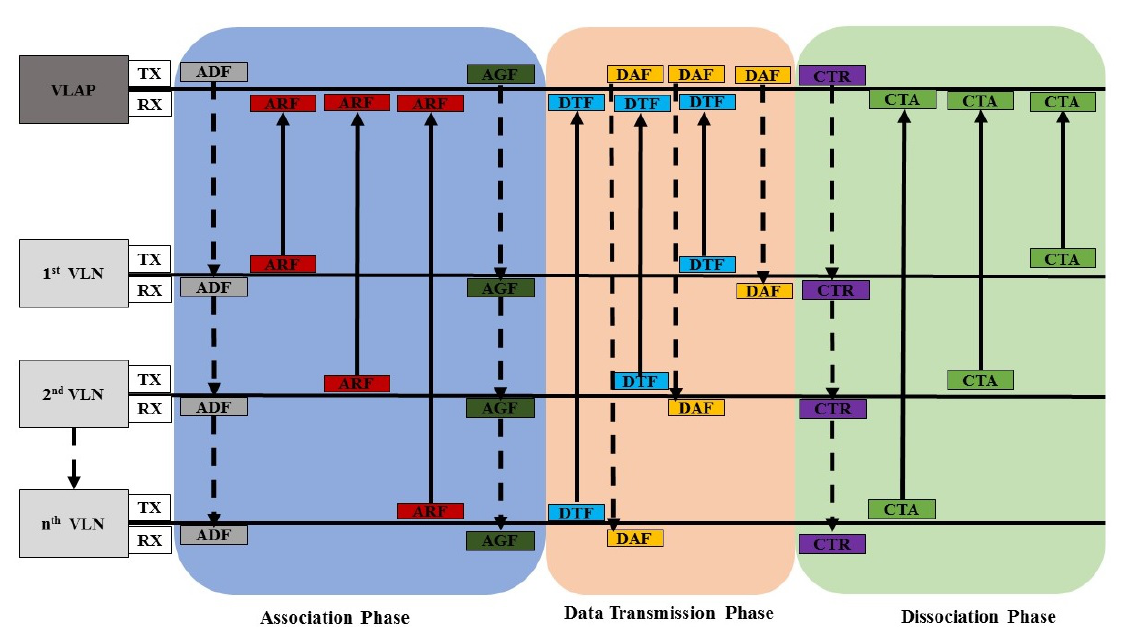
Figure 2. The adaptive polling medium access Ccontrol